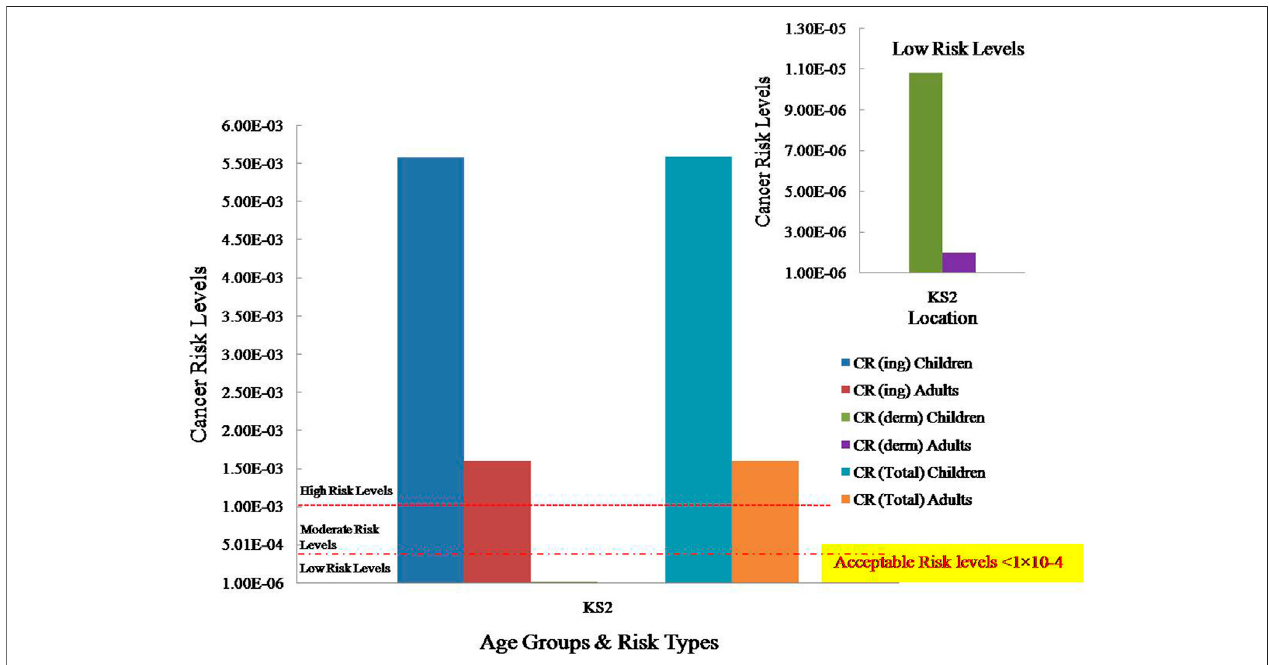
FIGURE 5 | Cancer risk from sediment-bound PAHs in the Ulsan coastal area (KS2).